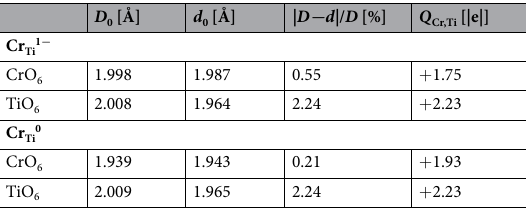
Table 3. List of apical ( D ) and basal ( d ) bond length in CrO 6 and TiO 6 octahedra, | D − d |/ D percentages, and Bader effective charge for Cr and Ti ions for Cr Ti1 − and Cr Ti0 defects in